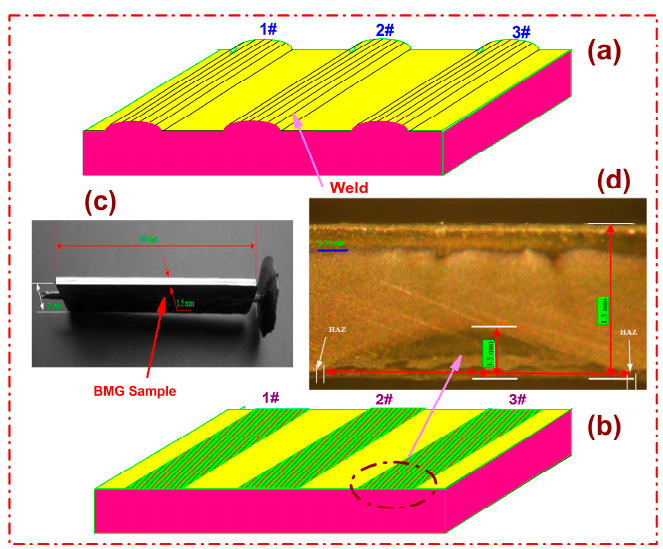
Figure 1. X ‐ ray diffraction (XRD) patterns for the as ‐ cast alloy and consubstantial alloy powders.